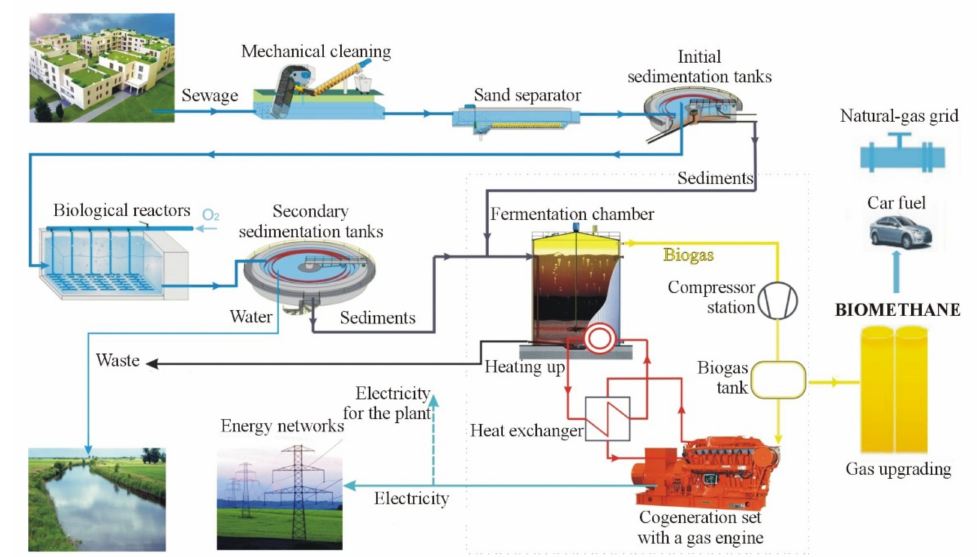
Figure 12. Economic use of BG obtained from sewage